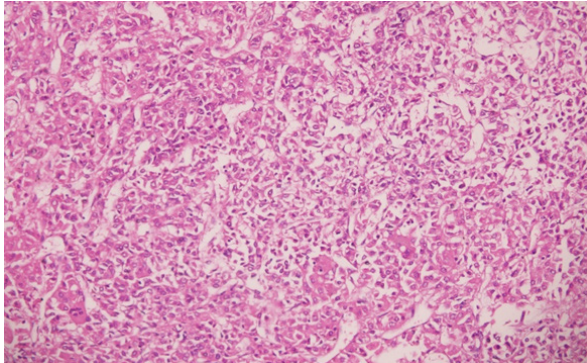
Figure 1: Photomicrograph showing fetal fetal cells arranged in a nest and thin trabeculae showing characteristic alternating light and dark pattern. (HE stain, X 100)